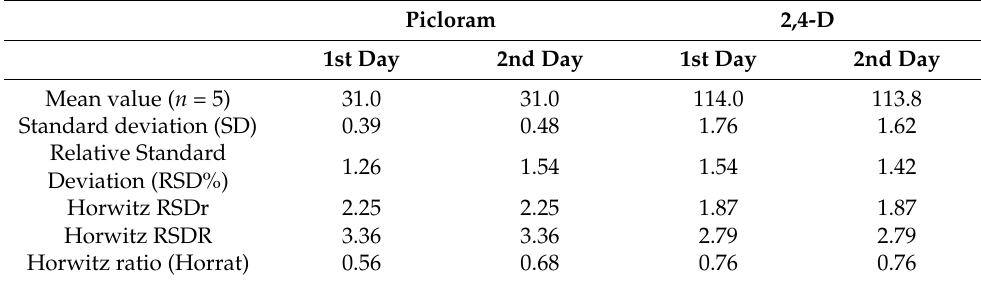
Table 2. Reproducibility for picloram and 2,4-D.